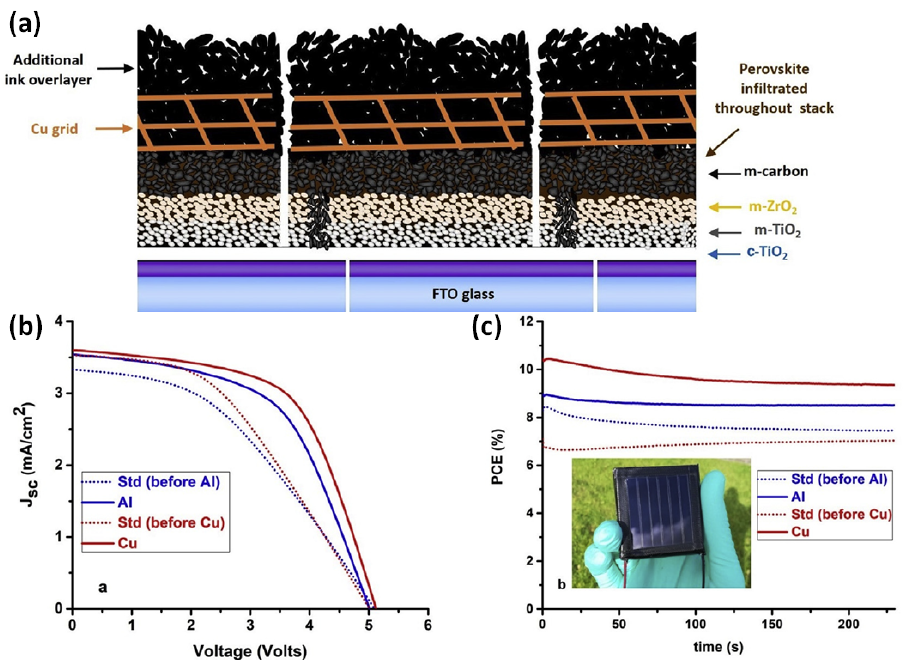
Figure 22. ( a ) Schematic representation of a module with copper grid. ( b ) J–V curves of the 11.7 cm 2 modules before and after grid application. ( c ) Stabilized PCEs of modules before and after the placement of metallic grids. Inset shows the photo of an 11.7 cm 2 module [100]. (Reproduced from Ref. [100], 10.1016/j.cap.2020.02.009, with permission.)